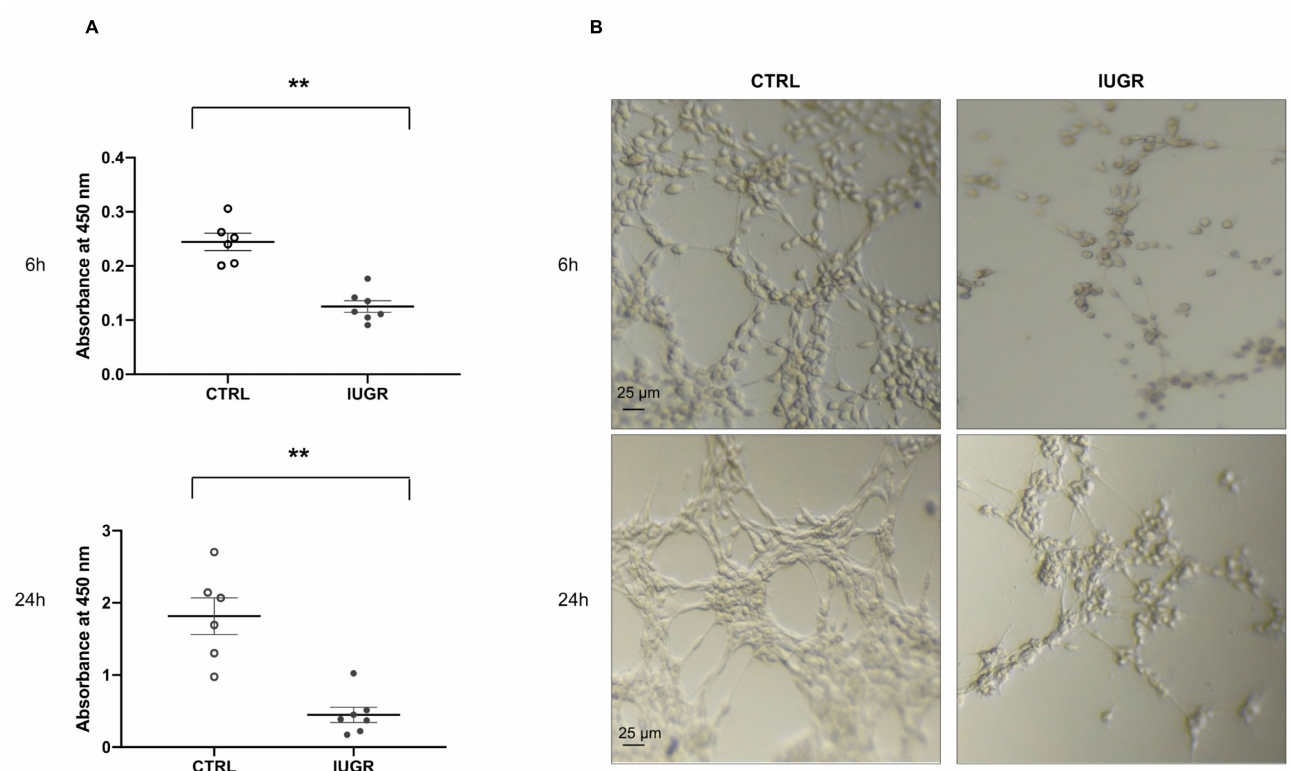
Figure 4. Proliferation and capillary-like structure formation properties of ECFCs. The proliferation capacity of CTRL- ECFCs and IUGR-ECFCs isolated from six-month-old male rats was quantified using BrdU incorporation at 6 and 24 h; n = 6–7 animals/group; ** p < 0.01 ( A ). The capillary-like outgrowth sprouts were evaluated using Matrigel cultures at 6 and 24 h in CTRL-ECFCs and IUGR-ECFCs isolated from six-month-old male rats. Magnification (5 × ) ( B ). These pictures are representative images from n = 5–6 animals/group. Scale bar = 25 µ